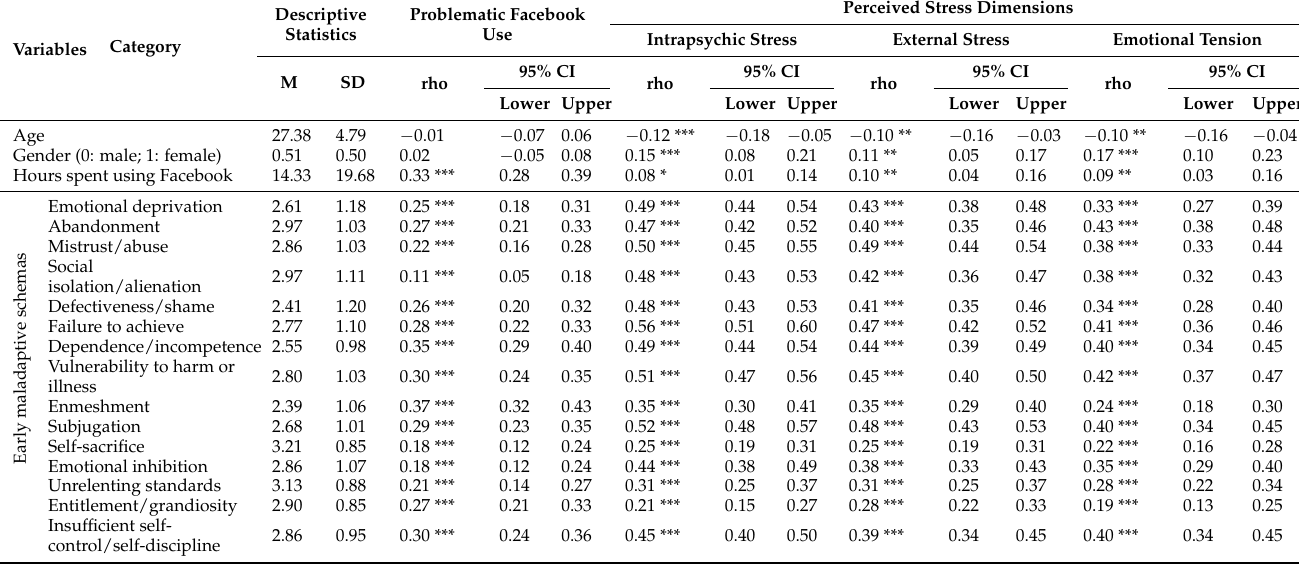
Table 3. The relationship between problematic Facebook use, perceived stress dimensions, and other analyzed